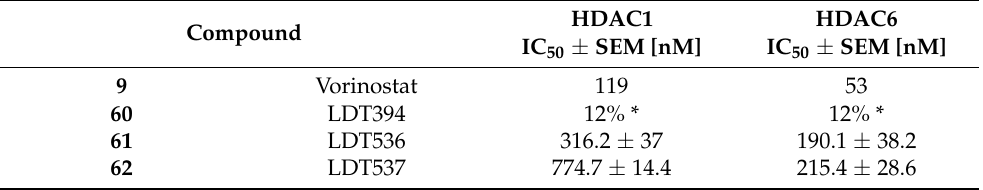
Table 5. In vitro inhibition of HDAC1 and HDAC6 by 60 – 62 and reference compound